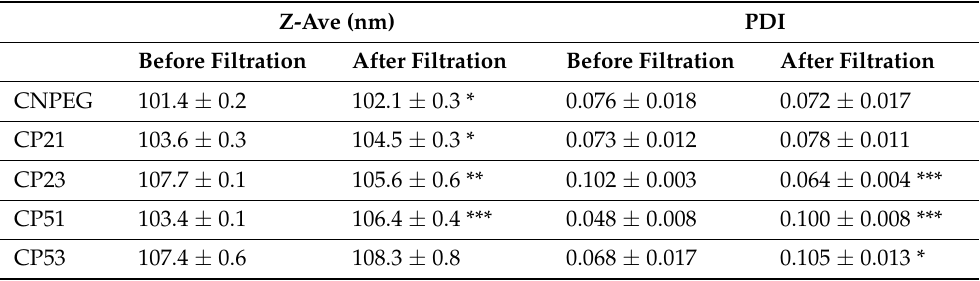
Table 6. The impact of aseptic filtration on droplet size (Z-ave) and polydispersity index (PDI) of C-PEG-NEs. Z-Ave (nm) PDI Before Filtration After Filtration Before Filtration After Filtration CNPEG 101.4 ±